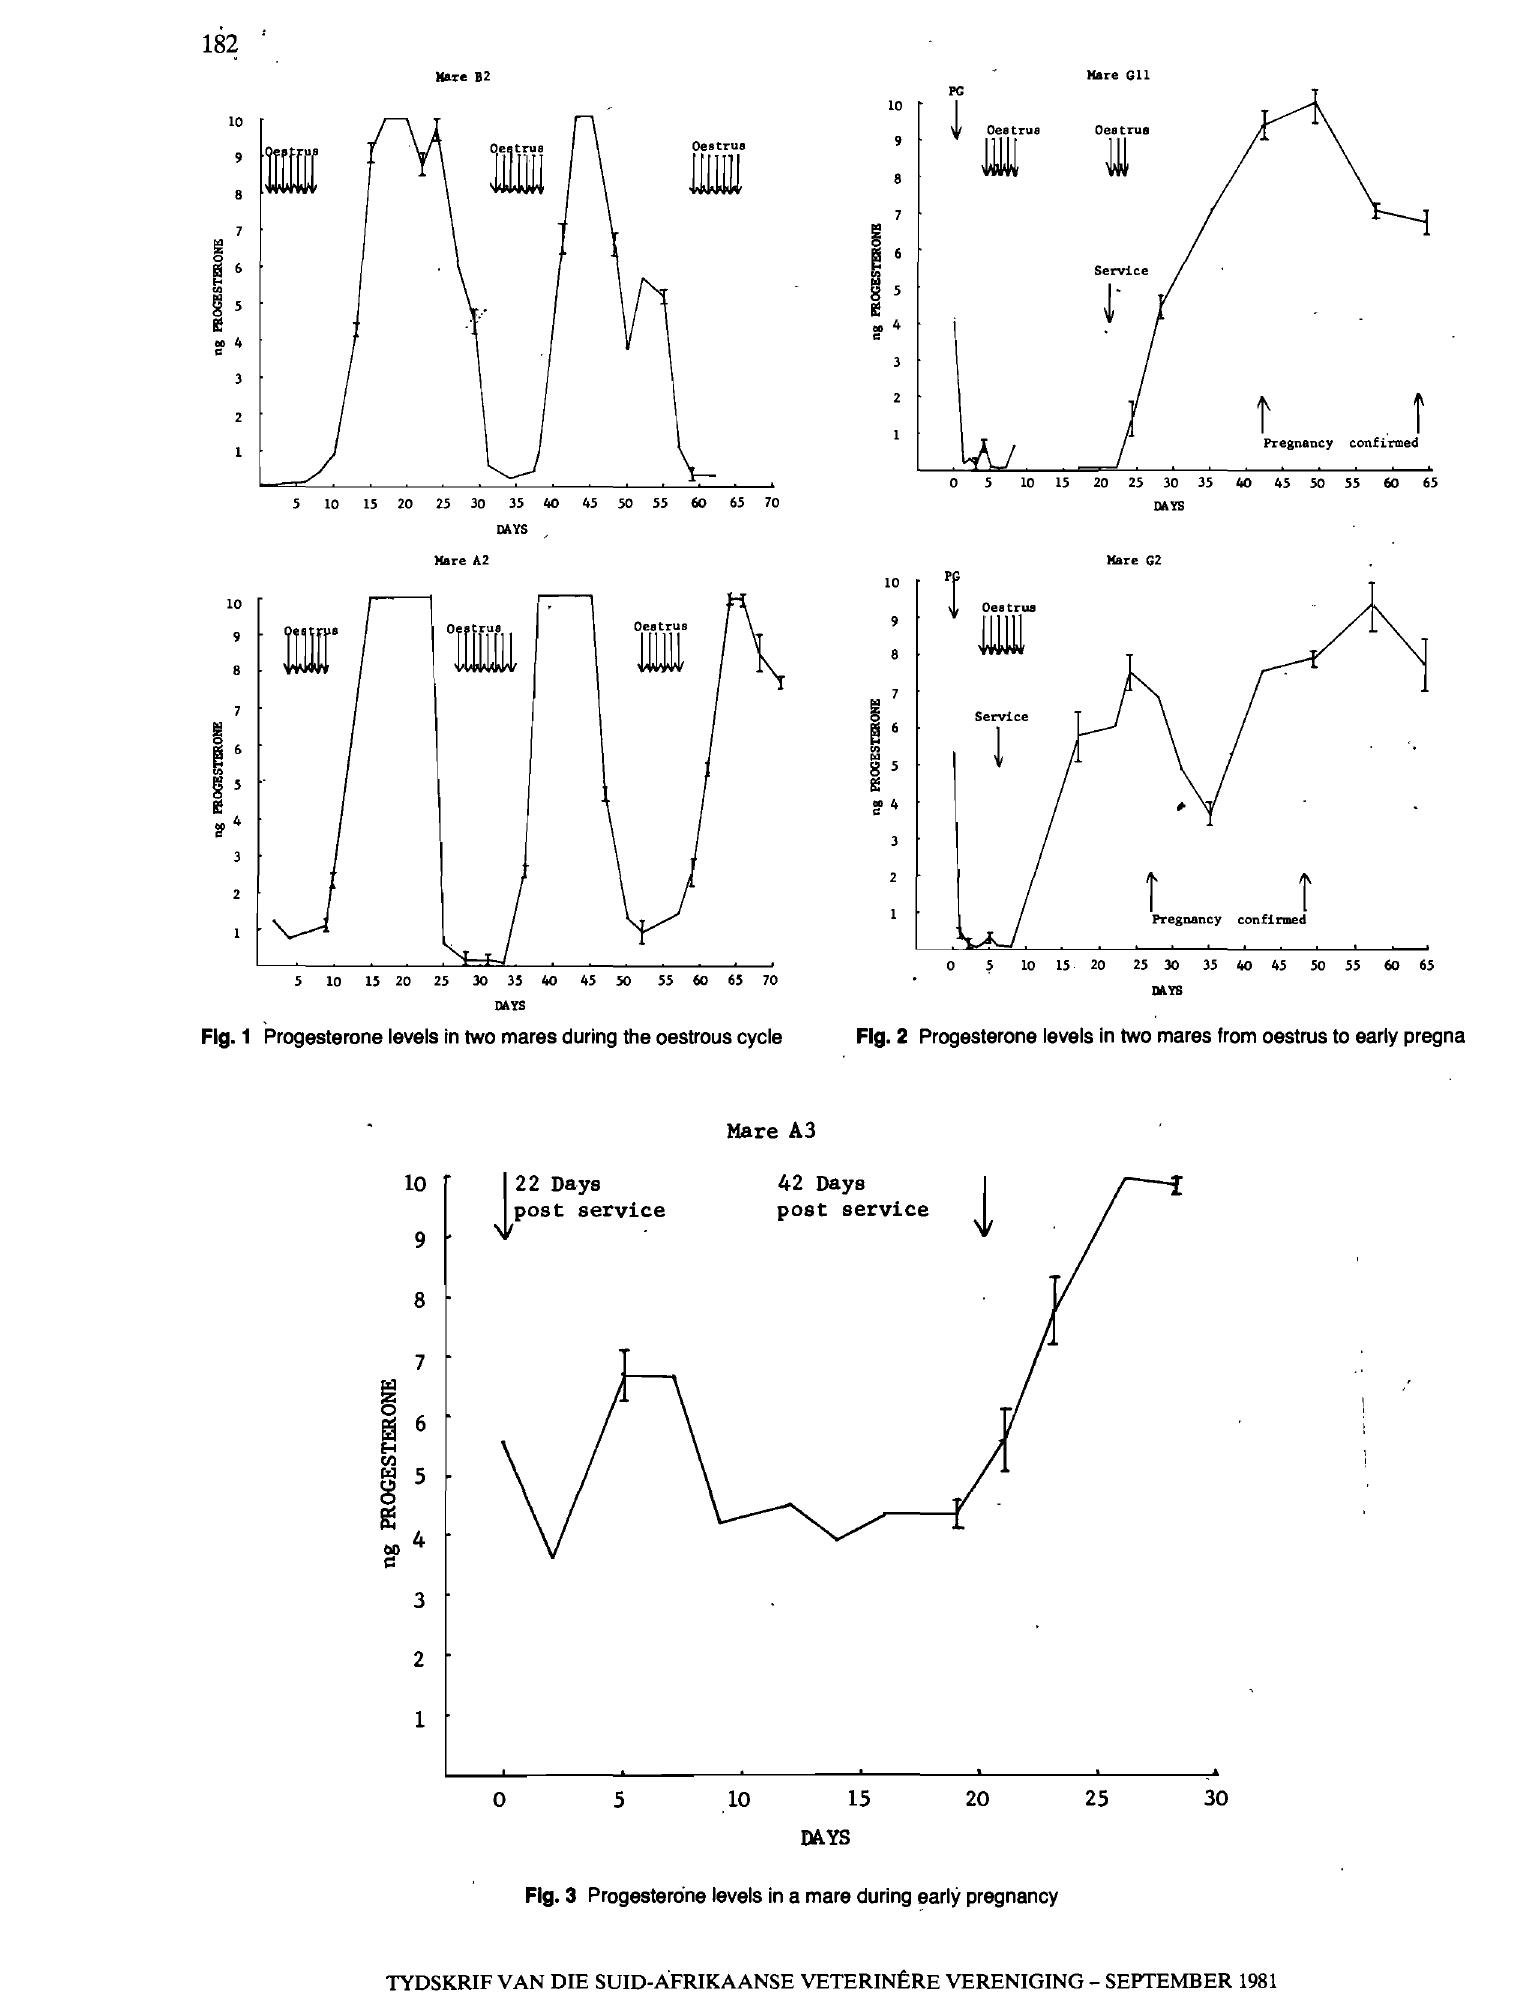
Fig. 3 Progesterone levels in a mare during early